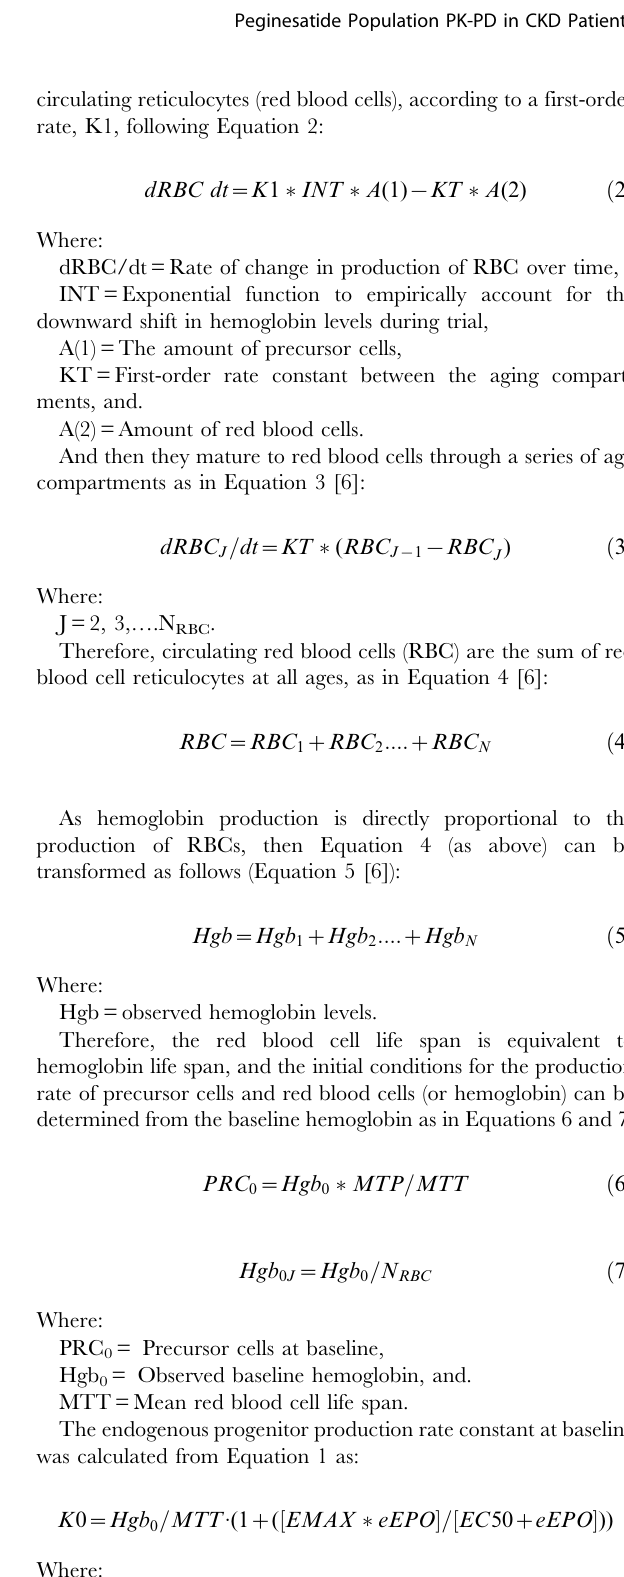
Where: eEPO =Endogenous erythropoietin for each individual at the start of the trial. In the study, baseline erythropoietin levels were not measured in all patients. Instead of using actual baseline erythropoietin values to calculate the endogenous progenitor production rate constant at baseline, the values were estimated in the form of the residual effect of previous ESAs (RSA).